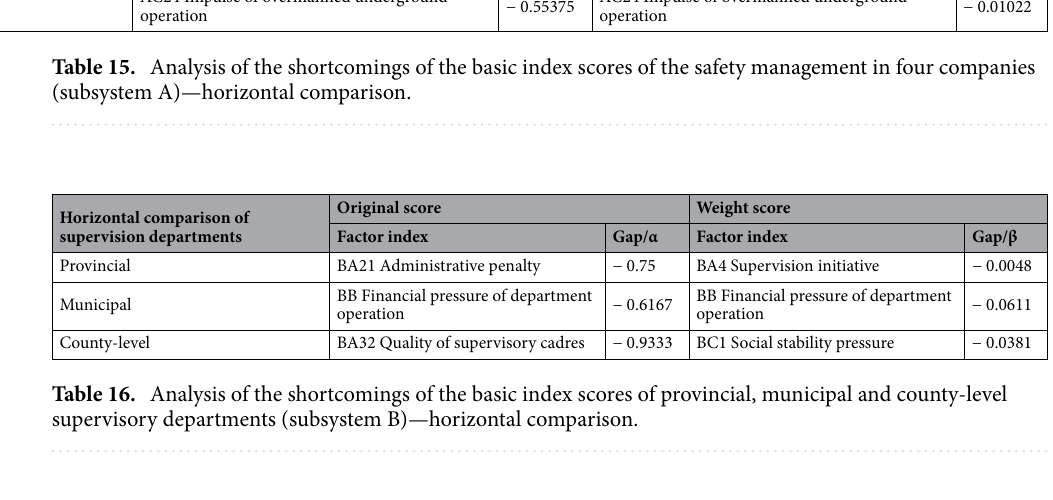
Horizontal comparison of indexes in subsystem C of three enterprises